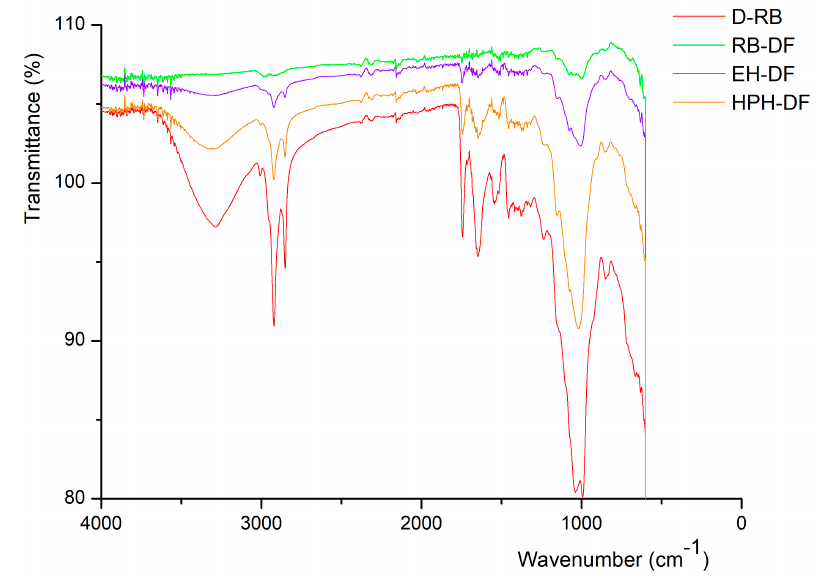
Figure 3. Infrared spectra of rice bran dietary fiber at different treatment stages. D-RB defatted rice bran, EH-DF cellulase enzymatic treatment rice bran dietary fiber, HPH-DF high-pressure treatment rice bran dietary fiber, RB-DF rice bran dietary fiber.